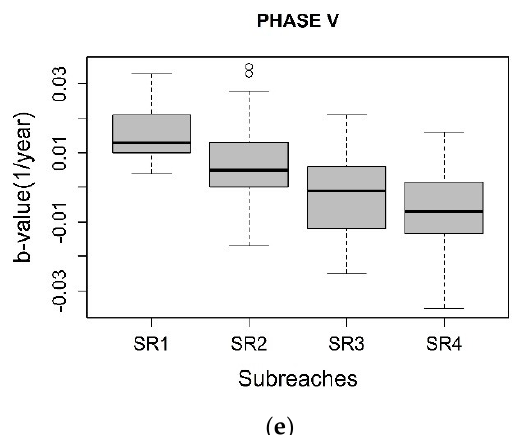
Figure 4. Temporal and spatial variations in nonlinear rate of vertical adjustment ( b -value).